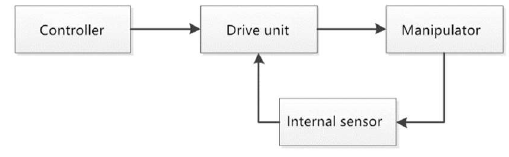
Figure 1. Closed-loop servo system